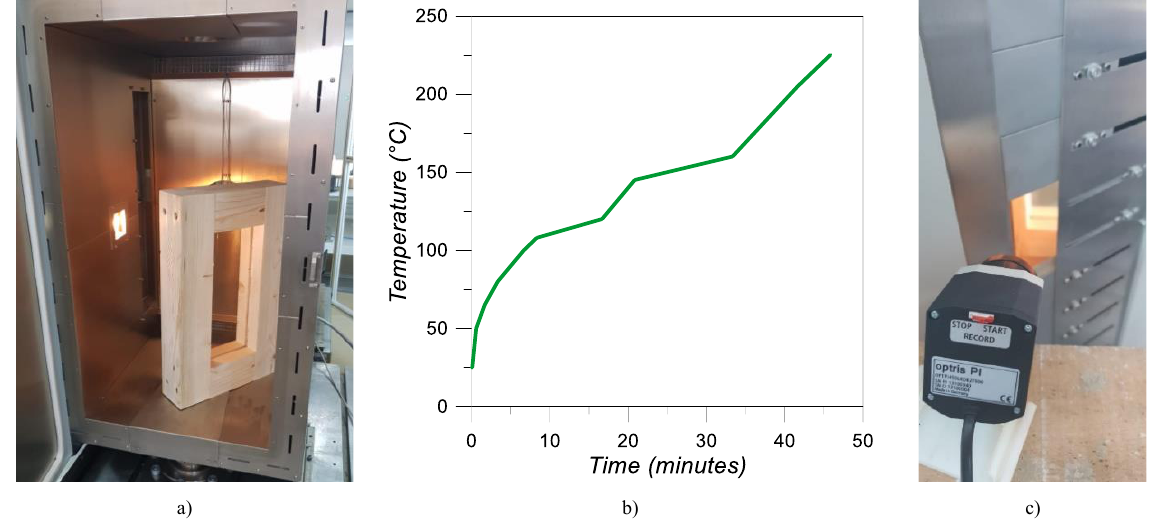
Fig. 4 Small-scale CLT-glass prototype: a) test setup, b) imposed temperature-time history and c) thermal